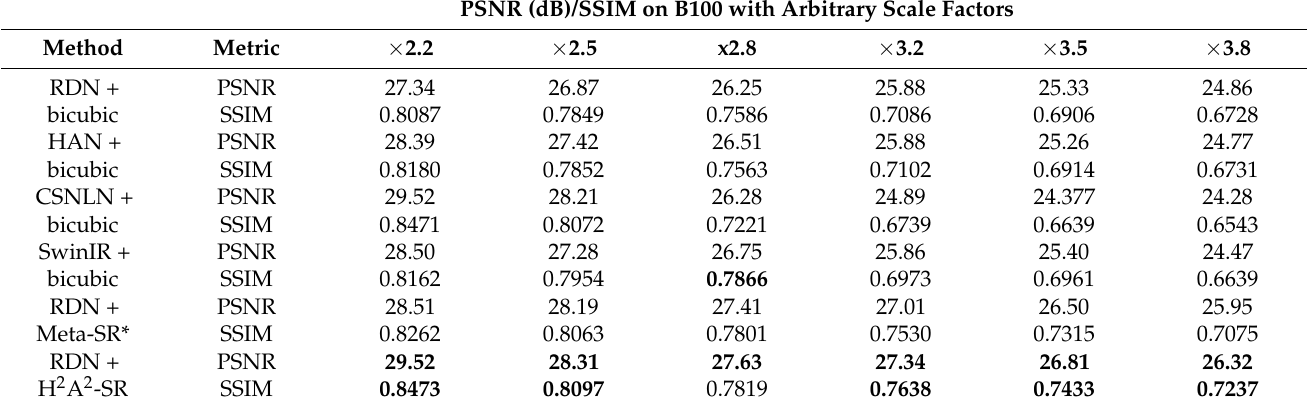
Table 5. Quantitative comparison of the state-of-the-art SR methods.